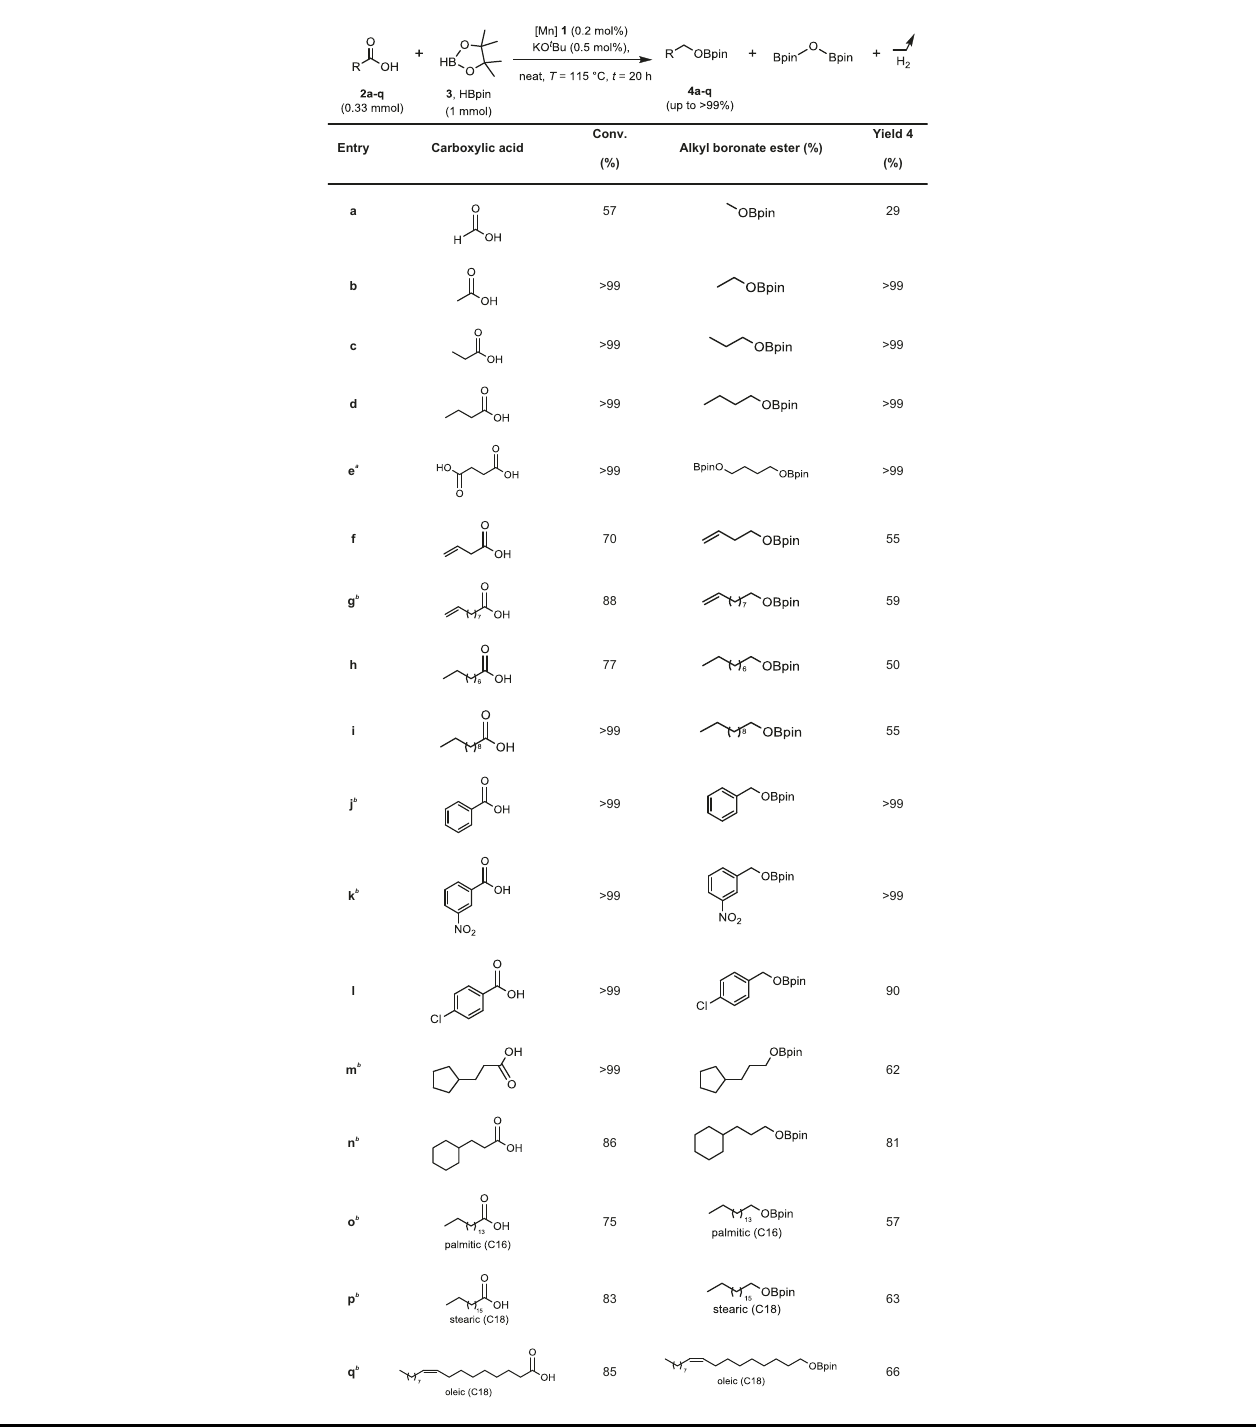
Table 1 Hydroboration of carboxylic acids using Mn complex 1 as catalyst